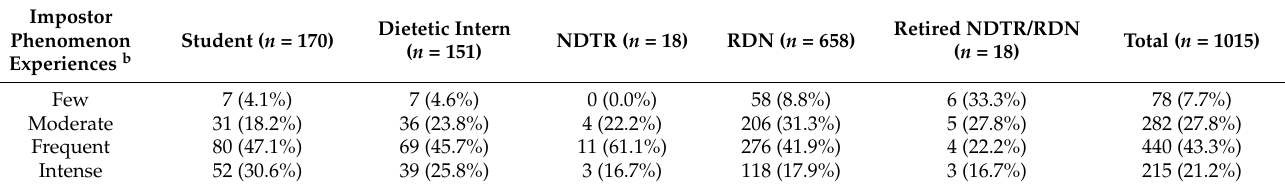
Table 2. Prevalence of the Impostor Phenomenon Experiences in Nutrition and Dietetics by Profes- sional Level a .